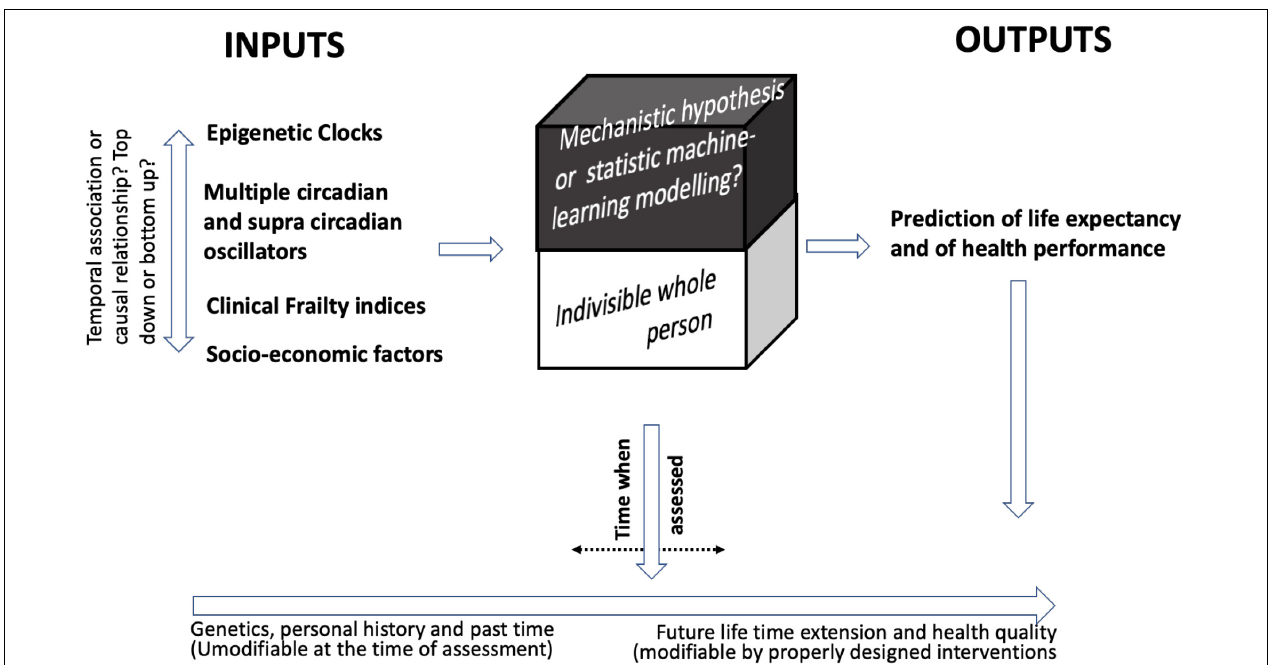
FIGURE 1 | In search for frailty markers. The figure depicts the relationships between the multiple determinants of frailty and lists categories of indicators that have been studied as predictors of age and health in aged people. From a biological point of view, an important role is played by epigenetic clocks and circadian oscillators even if a hierarchical relationship between the two and among them and the clinical frailty indices and socio-economic factors cannot be established. On the other hand, the framework and the data collection generated by these studies let us predict the birth of increasing reliable predictor indices of residual life expectancy and health which may be assessed at various times of life trajectory. The so far available data also allow to predict that interventions able to change the pacing of these events may be developed. The figure highlights some aspects, such as: the dynamic nature of aging and frailty; the problem of identifying the relationship between biomarkers of aging and frailty in a complex system and the importance of the time-frame of the observation; the attempt to extend the biological frailty to other aspects of the life of older subjects including socio-economic aspects; the need of a multilevel approach which may rely also on the use of AI and machine learning to adequately select the relevant data and integrate them modeling an appropriate